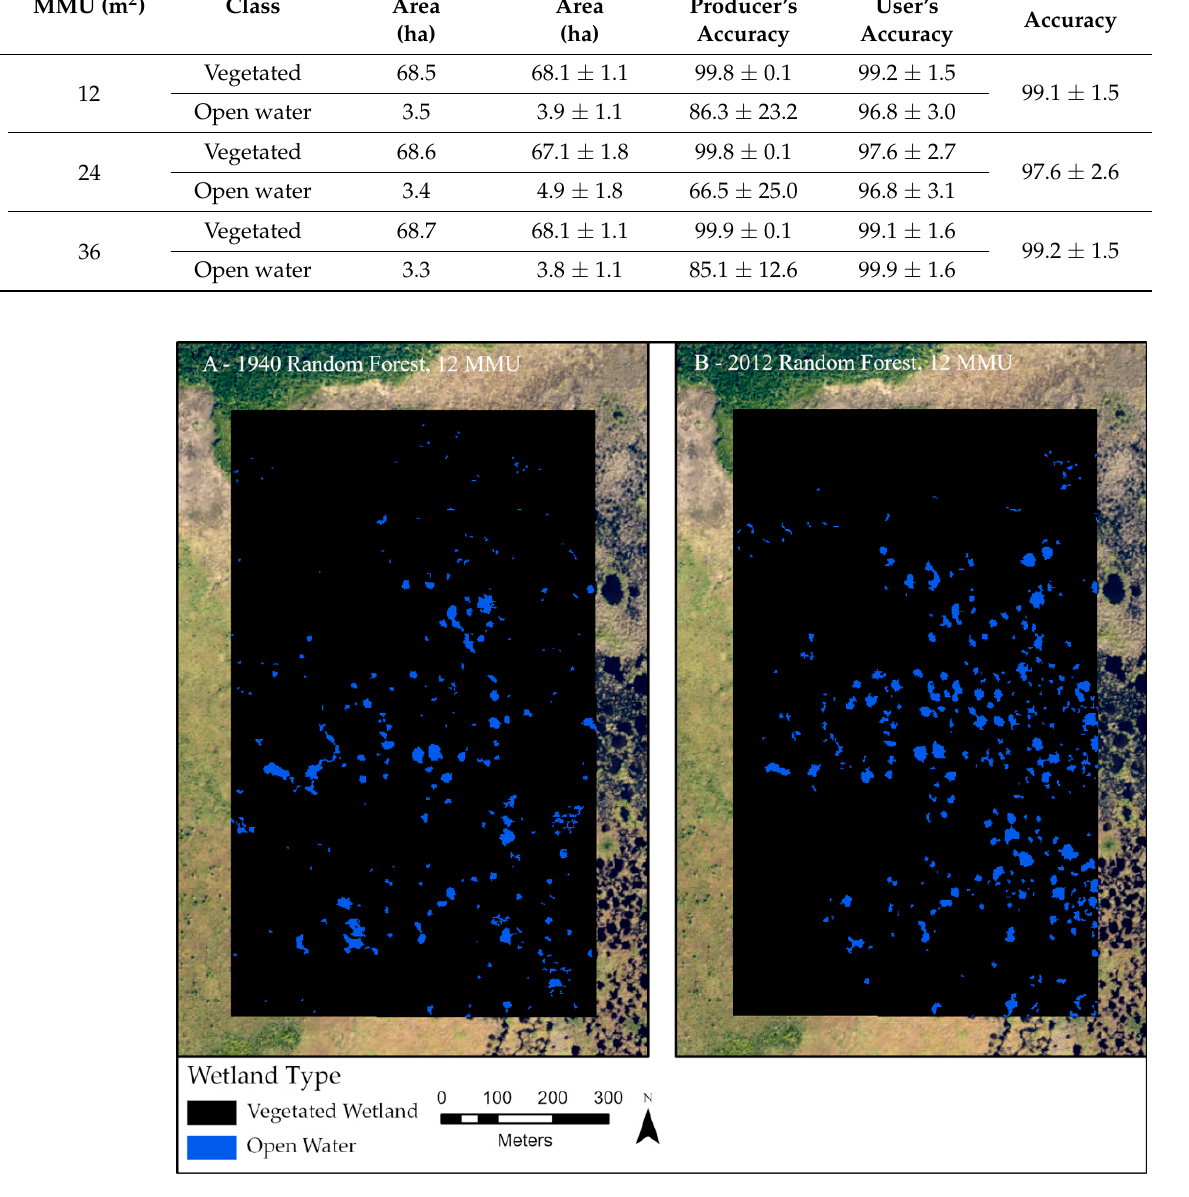
Figure 5. ( A ) 1940 random forest land cover classification; ( B ) 2012 random forest land cover classification. Both classifications are shown at a 12 m 2 MMU.